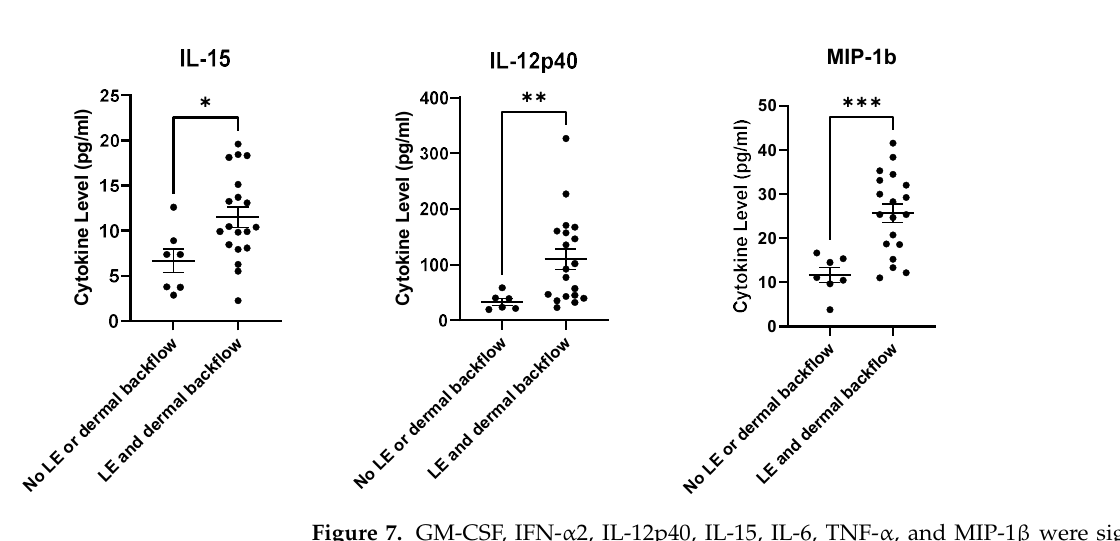
at pre-ALND in subjects with both clinical BCRL/LE and dermal backflow at 12-months post-RT Figure 7. GM-CSF, IFN-α2, IL-12p40, IL-15, IL-6, TNF-α, and MIP-1β were significantly higher at